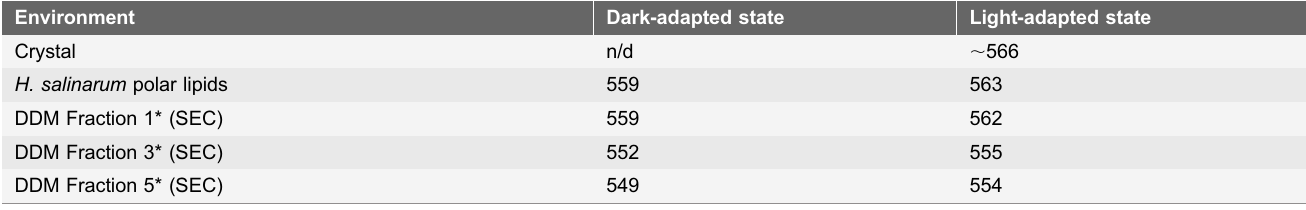
Table 1. Hm BRI absorption maxima in different environments